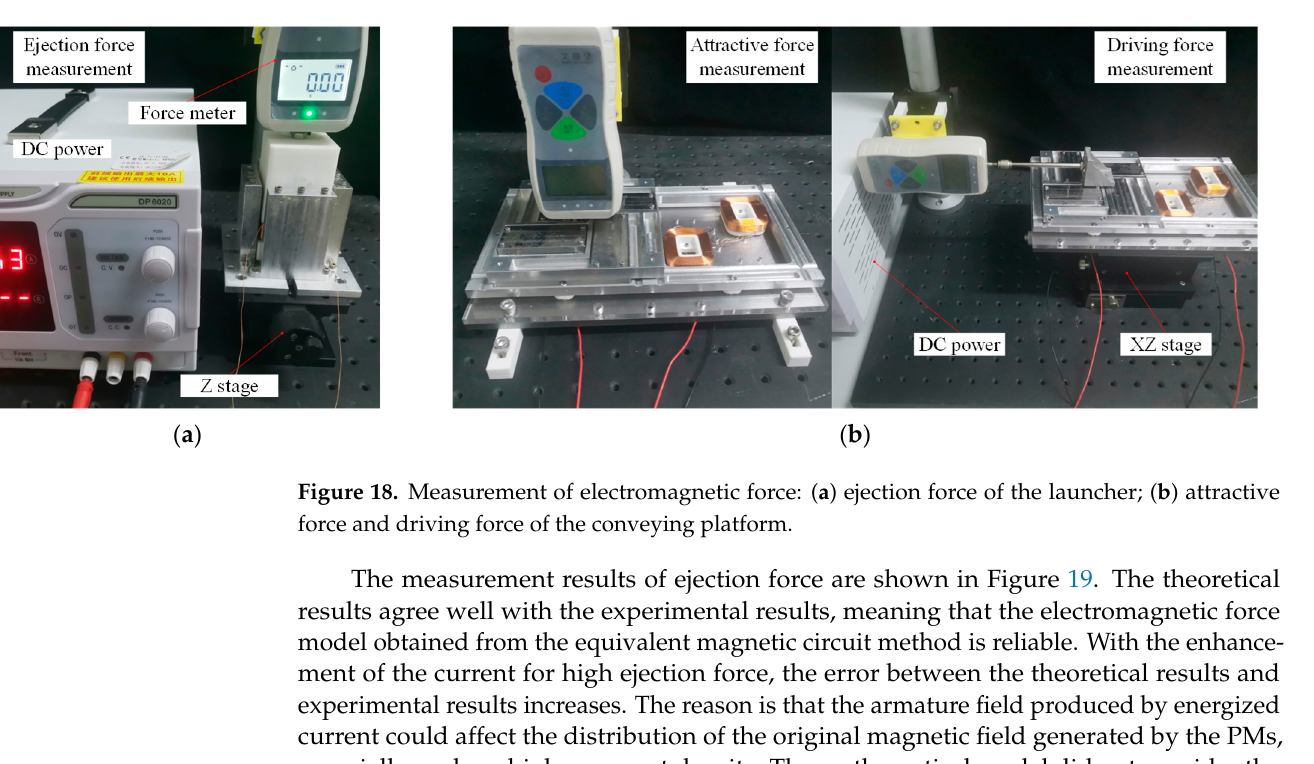
( b ) Figure 19. Ejection force of the launcher: ( a ) ejection force versus current and ( b ) ejection force versus position. The test results of attractive force and driving force are shown in Figure 20. The re- sults show that the large attractive force between the mover and the fixed part of the conveying platform is achieved. However, there is an error between the FEM result and 0.0